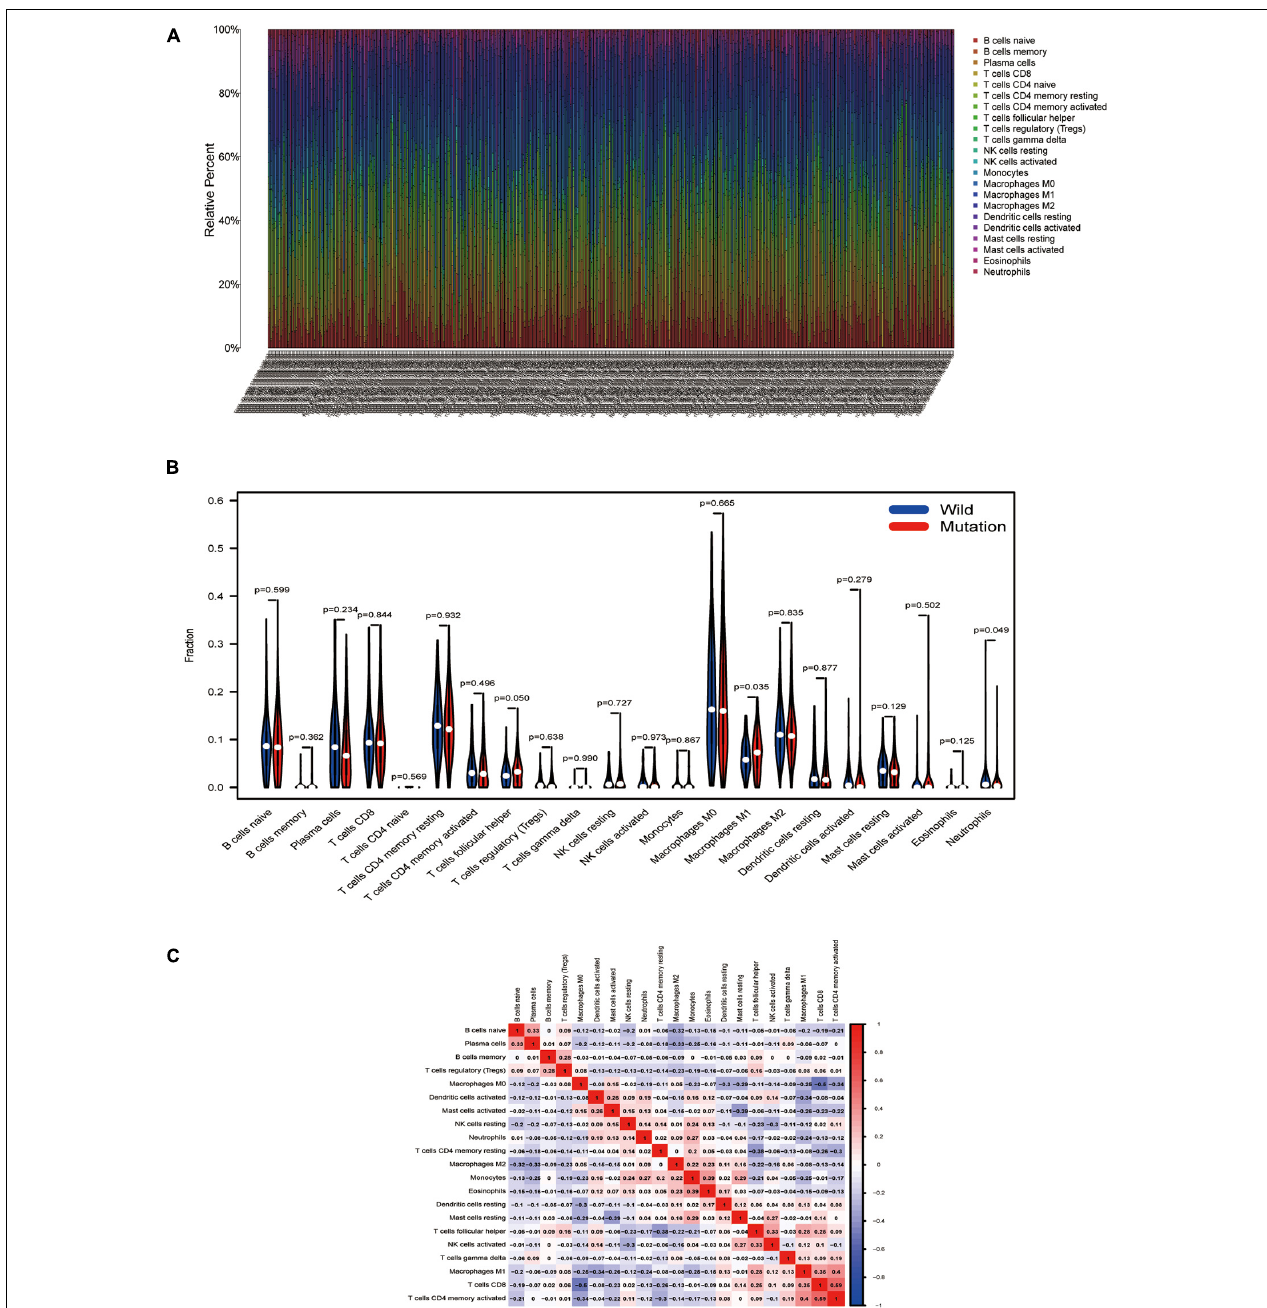
FIGURE 6 | TTN mutation is correlated with tumor-infiltrating immune cells. (A) The stacked bar chart shows the distribution of 22 immunocytes in each sample. (B) Violin plot displaying the differentiated immunocyte infiltration between the mutated TTN and the wild-type TTN group. Blue refers to the wild-type TTN group, and red reflects the TTN -mutant group. The p -value is shown in the figure. (C) Correlation matrix of immunocyte ratios. The red color represents positive correlation, and the blue color represents negative